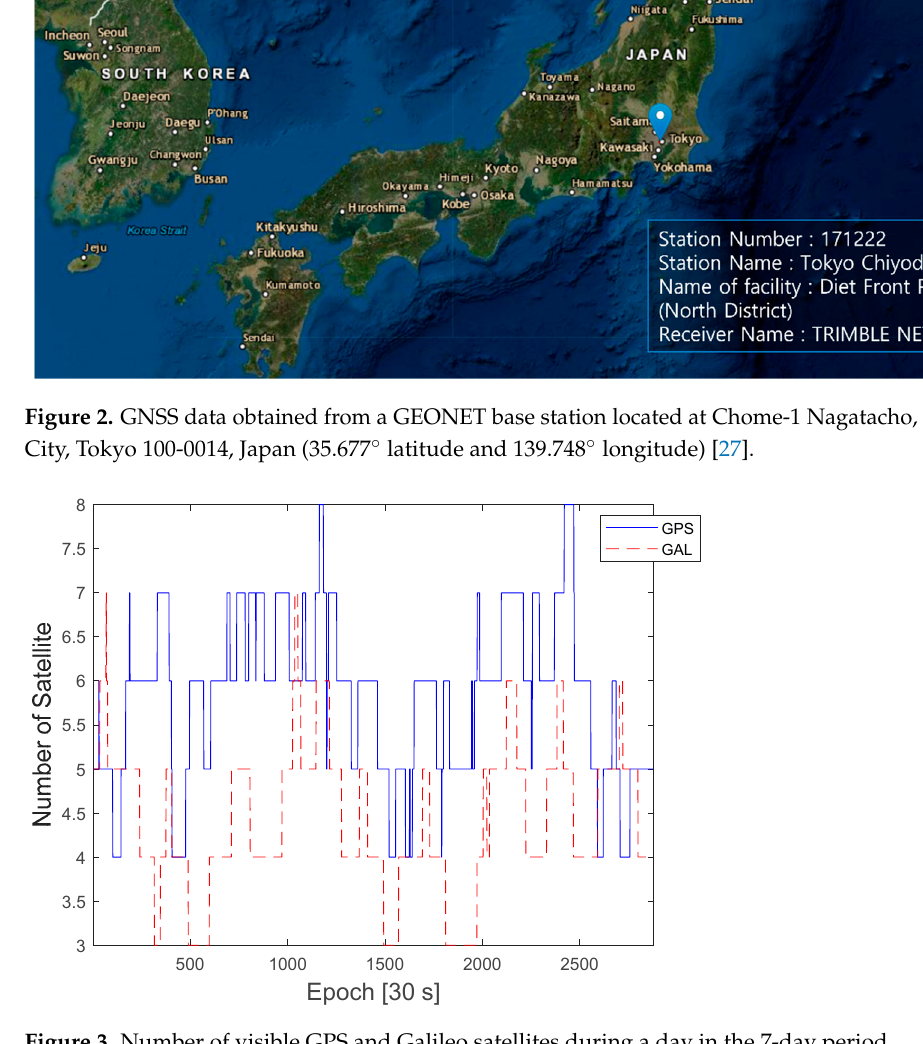
Figure 3. Number of visible GPS and Galileo satellites during a day in the 7-day period.